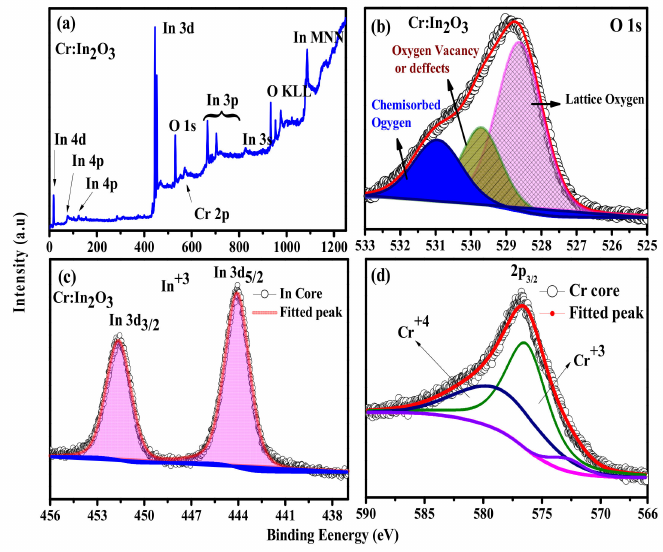
Figure 4. X-ray photoelectron spectra of ( a ) survey scan, ( b ) oxygen core level ( c ) indium core level and ( d ) chromium core level for the Cr doped In 2 O 3 thin